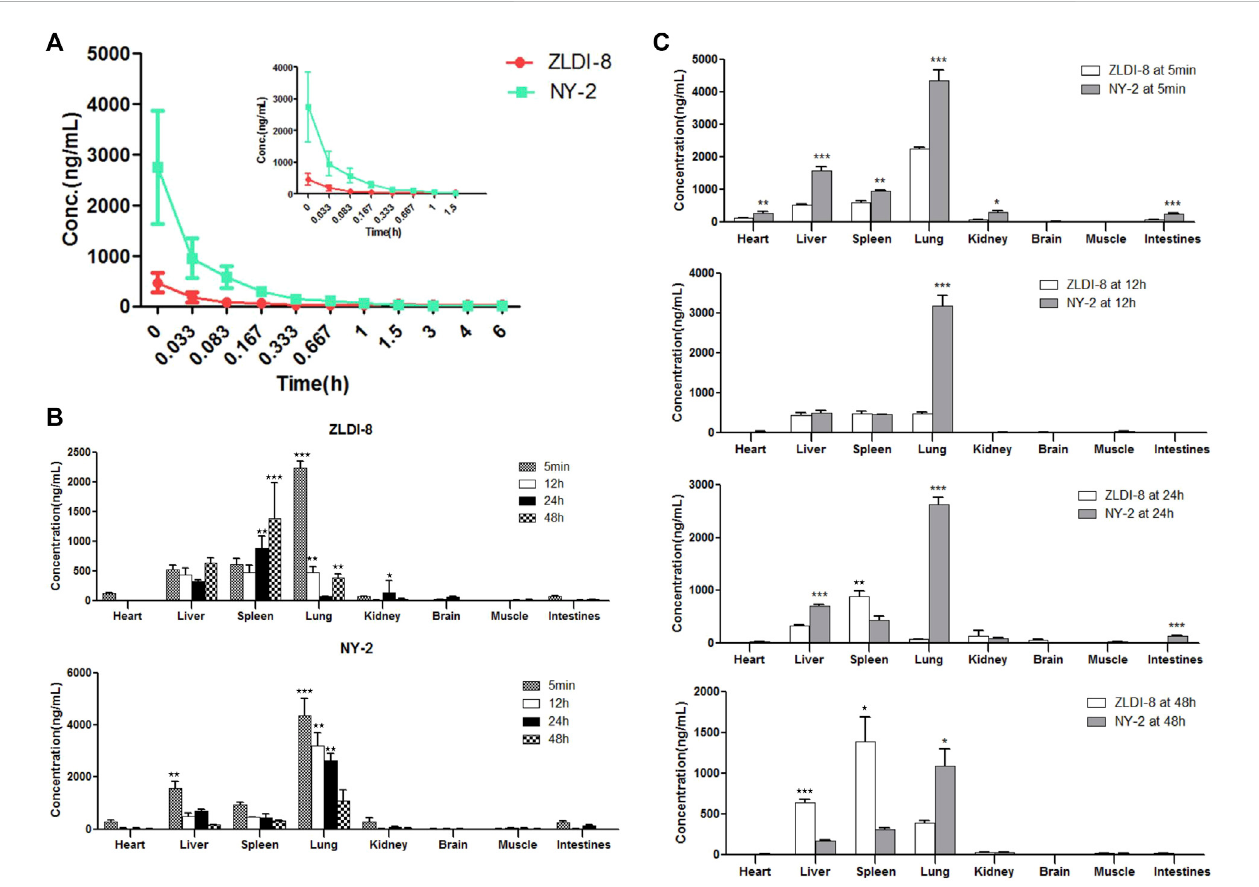
FIGURE 3 Pharmacokinetics and tissue distribution of ZLDI-8 and NY-2 in rats. Comparison of ZLDI-8 and NY-2 drug time curves (A) . Distribution of ZLDI-8 and NY-2 at 5 min, 12, 24, and 48 h (B) . Comparison of tissue distribution between ZLDI-8 and NY-2 at 5 min, 12, 24, and 48 h (C) . * p < .05, ** p < .01, *** p < .001 ( n = 6), *signi fi cantly